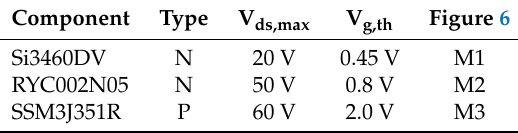
Table 3. Commercial off-the-shelf MOSFETs.